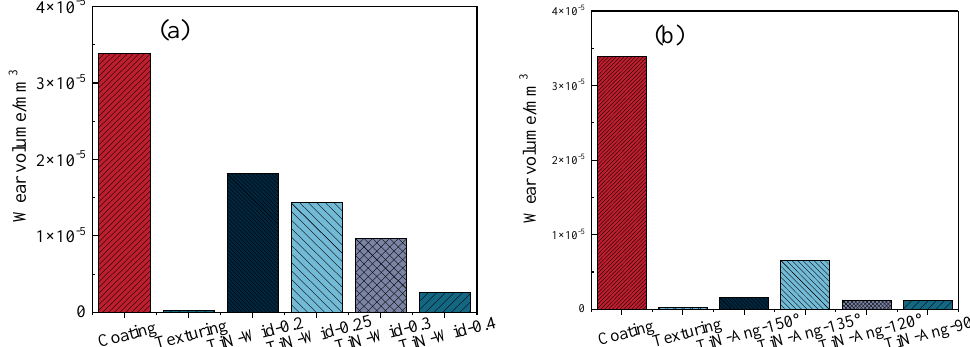
Figure 11. Wear volume of ( a ) different groove widths and ( b ) different groove angles.